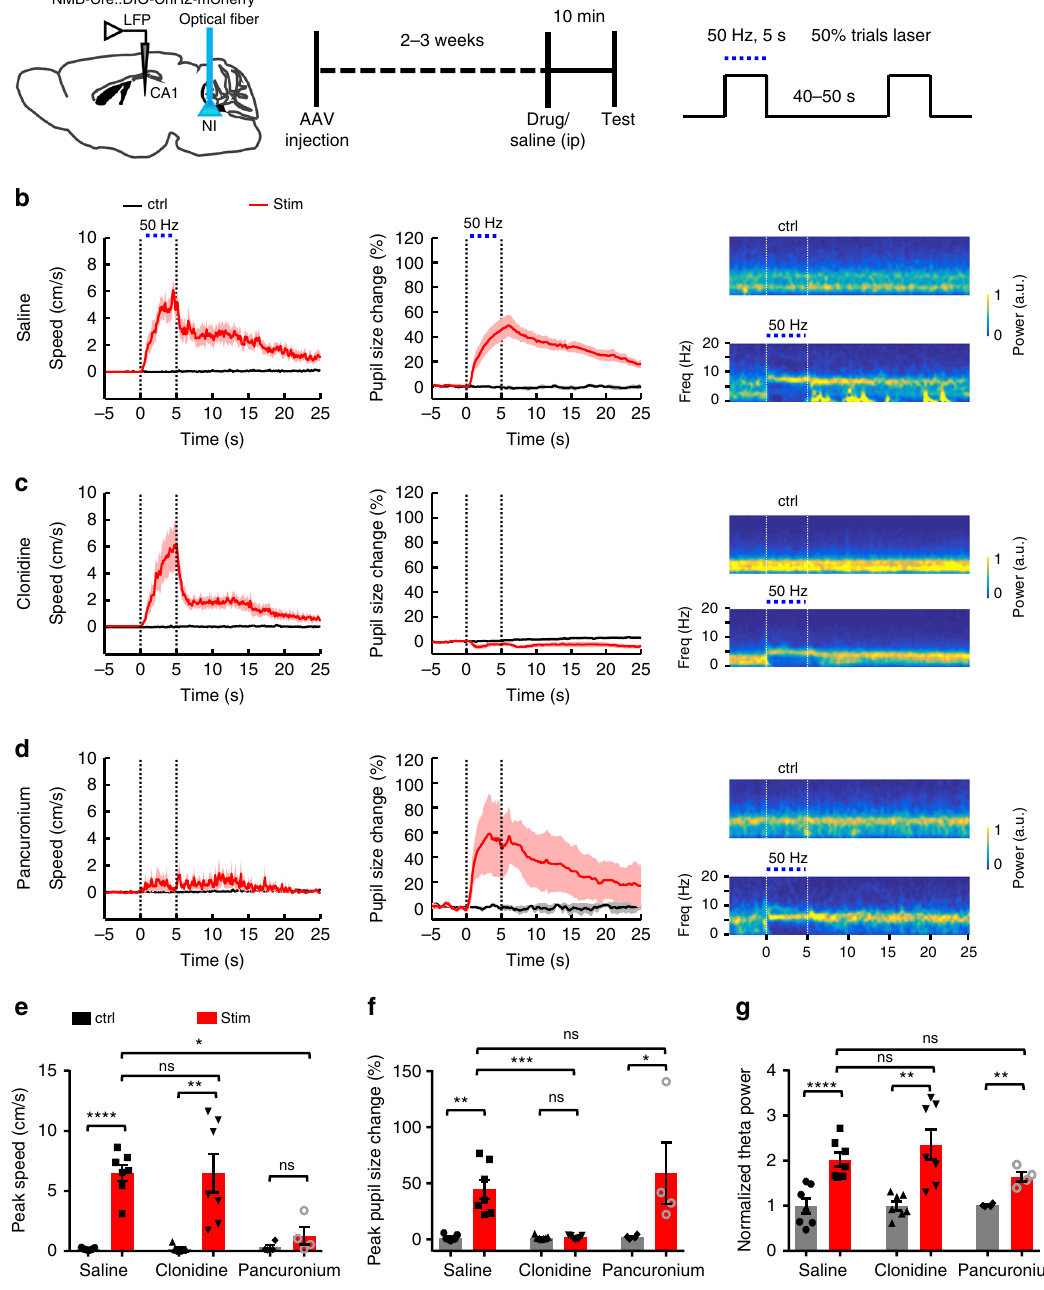
Fig. 4 The effect of NI NMB neurons on locomotion, arousal, and theta power are decomposable. a Schematics show the method of optogenetic stimulation of NI NMB neurons (left), time line of behavior test (middle), and stimulation protocol (right). b The effect of optogenetic stimulation on average locomotor speed (left), pupil diameter change (middle), and grand average of LFP spectrograms (right) for NMB-NI ChR2 mice with saline control injection (ip; n = 7 mice). c The effect of applying the adrenergic alpha-2 receptor agonist clonidine (0.1 mg kg − 1 , ip) of NI NMB neurons ( n = 7 mice). d The effect of applying the muscle relaxant pancuronium (0.18 mg kg − 1 , ip; n = 4 mice). e – g Summary data of showing the effect of clonidine and pancuronium on locomotor speed change, pupil diameter change, and theta power change in response to optogenetic stimulation of NI NMB neurons. Shaded areas ( b – d ) and error bars ( e – g ) indicate SEM. * P < 0.05, ** P < 0.01, *** P < 0.001, **** P < 0.0001; ns, not signi fi cant; Paired t test and Mann – Whitney test; see Supplement Table 1 for detailed statistical analysis. Source data are provided as a Source Data fi le. LH, the LHb, and the IPN each form functional monosynaptic LHb ChR2-expresing terminals elicited EPSCs in six NI NMB connections to NI NMB neurons. Our results from these neurons (Fig. 5k). Stimulation of IPN ChR2-expresing terminals anatomical and electrophysiological experiments thus show that elicited pure IPSCs in 6/8 NI NMB neurons (Fig. 5m) and a NI NMB neurons received both GABAergic and glutamatergic mixture of EPSC and IPSC in 2/8 NI NMB neurons (Supplemen- projections from the MS, the LH, and the IPN, and exclusively tary Fig. 8j). These responses were recorded in the presence of 4-AP glutamatergic projections from the LHb. and tetrodotoxin 44 , indicating that the neurons from the MS, the NATURE COMMUNICATIONS| (2020) 11:262